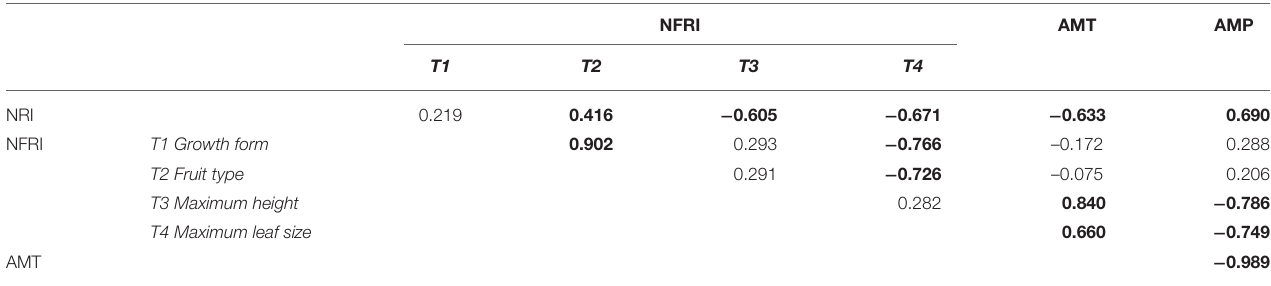
TABLE 1 | Results of the Pearson correlations analysis between phylogenetic structures (NRI) and functional structures (NFRI) of the four functional traits (growth form, fruit type, maximum height, and maximum leaf size), as well as the annual mean temperature (AMT) and annual mean precipitation